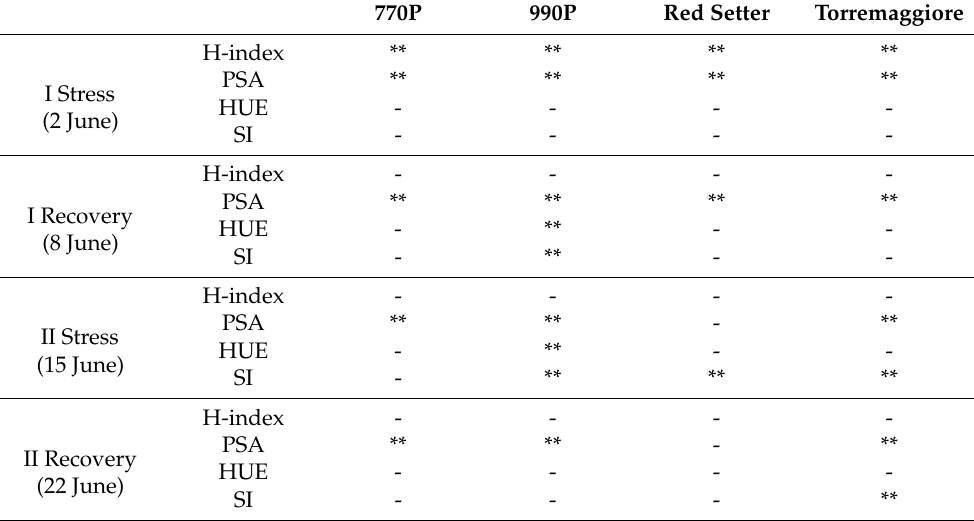
Table 1. ANOVA results on hyperspectral index (H-index), projected shoot area (PSA), HUE index, senescence index (SI), calculated at the end of each sub-cycle period. The significance of the ANOVA was indicated using ** symbol.